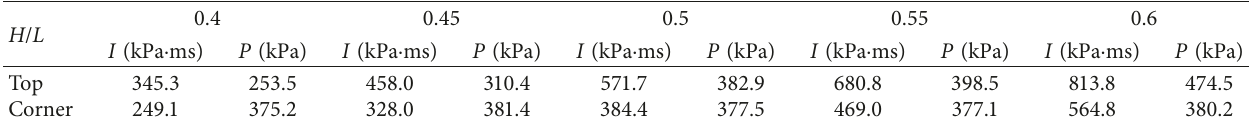
Table 7: Results of parameter analysis with different height-span